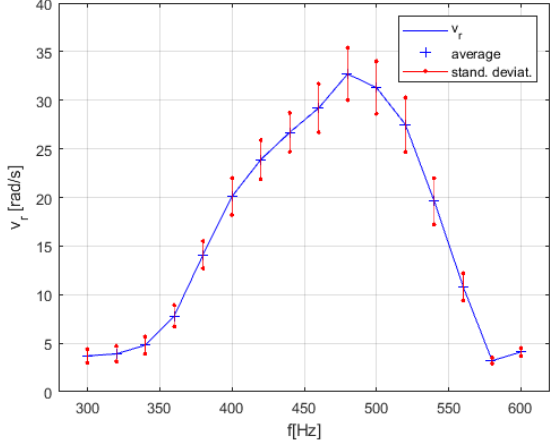
Figure 14. Accurate measurements of rotational velocity 𝑣 𝑟 resonant peak versus frequency f for the vibrational pot-like mechanism.